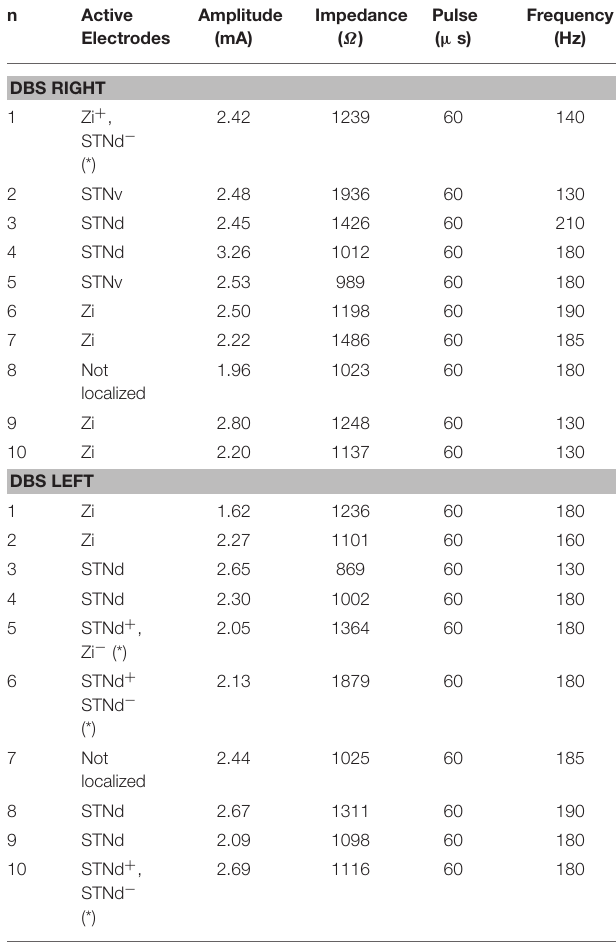
TABLE 2 | Localization of the active contact/contacts of the DBS electrode across Parkinson’s patients. n Active